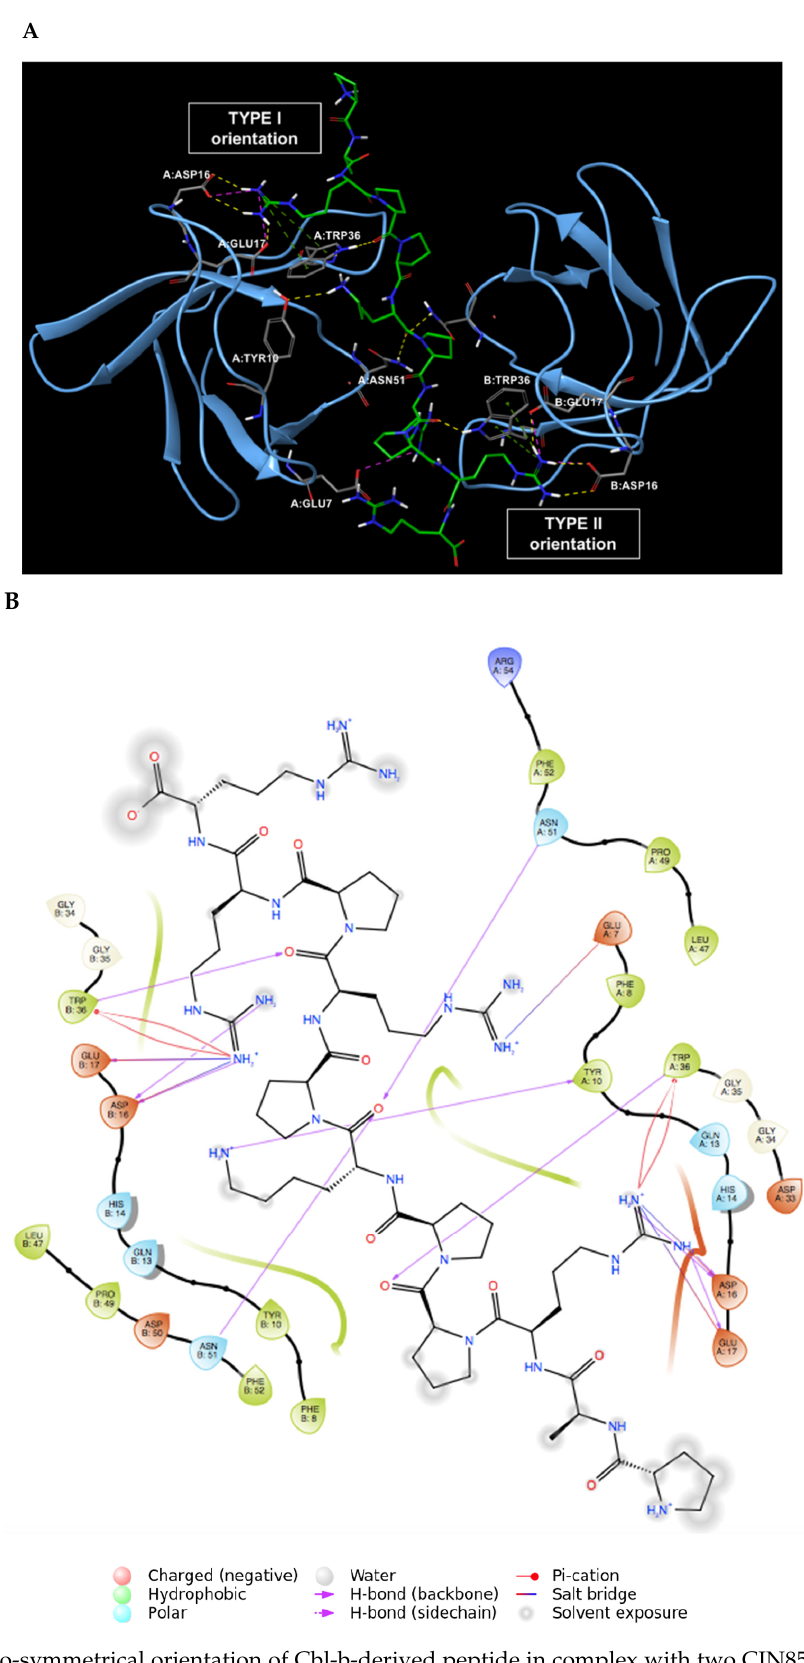
Figure 2. ( A ) Pseudo-symmetrical orientation of Cbl-b-derived peptide in complex with two CIN85 SH3 domains. The N-terminal region of the peptide is involved in the Type I orientation, while the C-terminus is engaged in the Type II orientation [21]. ( B ) 2D interaction diagram of Cbl-b peptide and the established interactions with CIN85 SH3 domains amino acids retrieved from PDB 2BZ8.